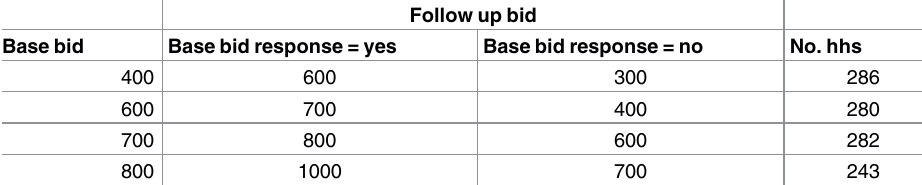
Table 8. Vector of bids and number of